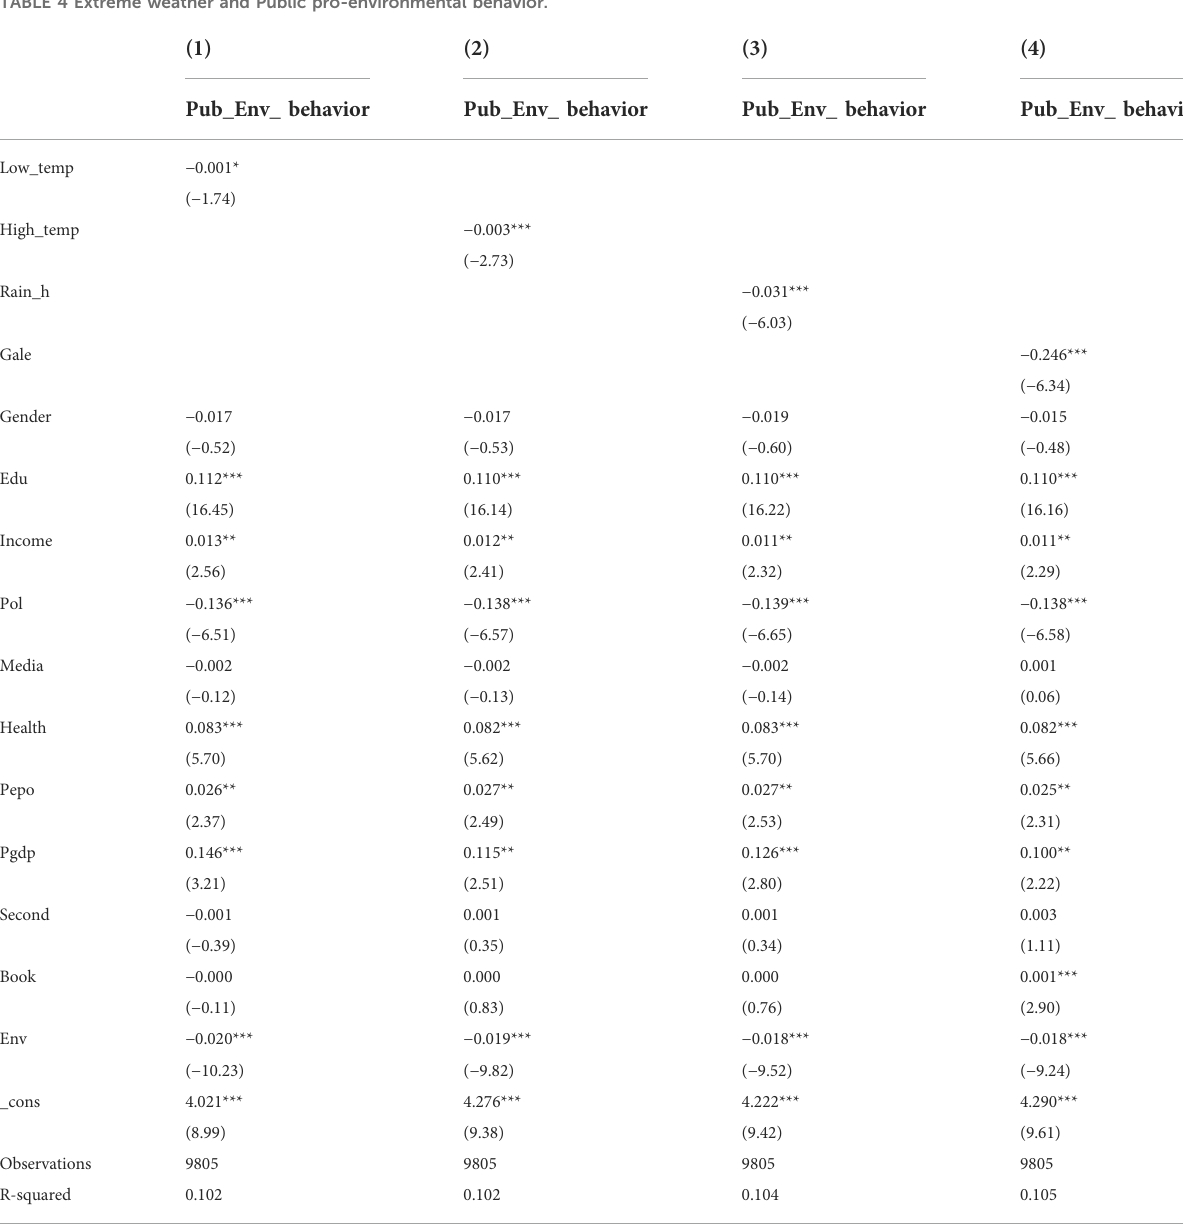
TABLE 4 Extreme weather and Public pro-environmental